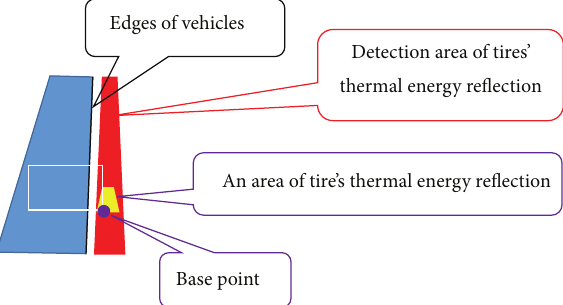
Figure 14: The position of the rectangle which shows a detected vehicle.